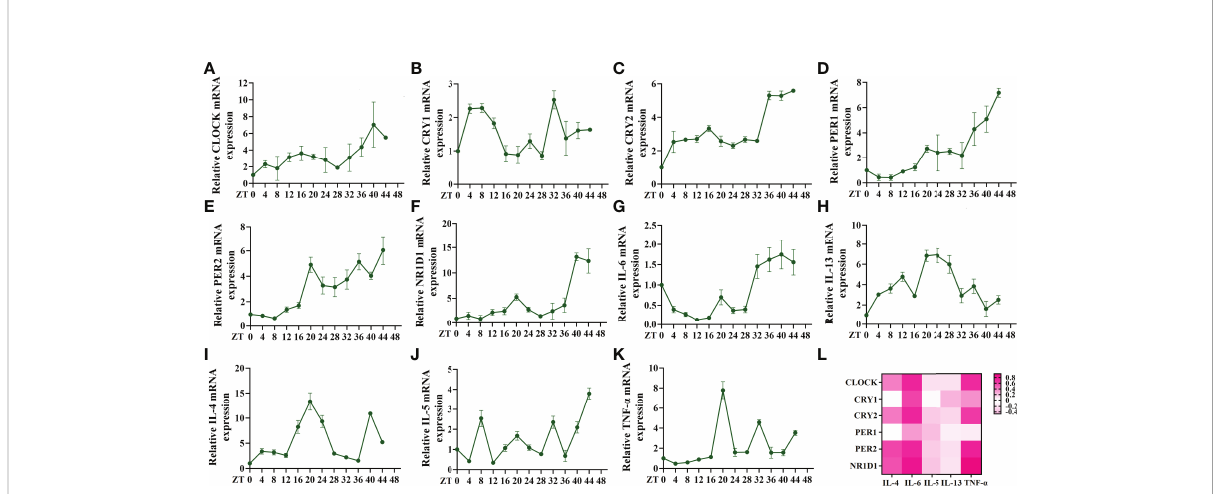
FIGURE 3 Serum shock induces circadian clock gene and in fl ammatory cytokine expression and association in 16HBE cells. (A – F) RT-qPCR analysis of the mRNA levels of circadian clock genes (CLOCK, CRY1, CRY2, PER1, PER2, and NR1D1) in 16HBE cells in response to serum shock synchronisation. (G – K) RT-qPCR analysis of the mRNA levels of in fl ammatory cytokines (IL-6, IL-13, IL-4, IL-5, and TNF-a) in 16HBE cells in response to serum shock synchronisation. (L) Heat map of the matrix coef fi cient correlation of each circadian clock gene and in fl ammatory cytokines. The stronger Pearson ’ s correlation coef fi cients (r) are represented in red. ZT= zeitgeber time. All data shown are representative data of one out of at least 3 independent experiments, Pearson ’ s correlation coef fi